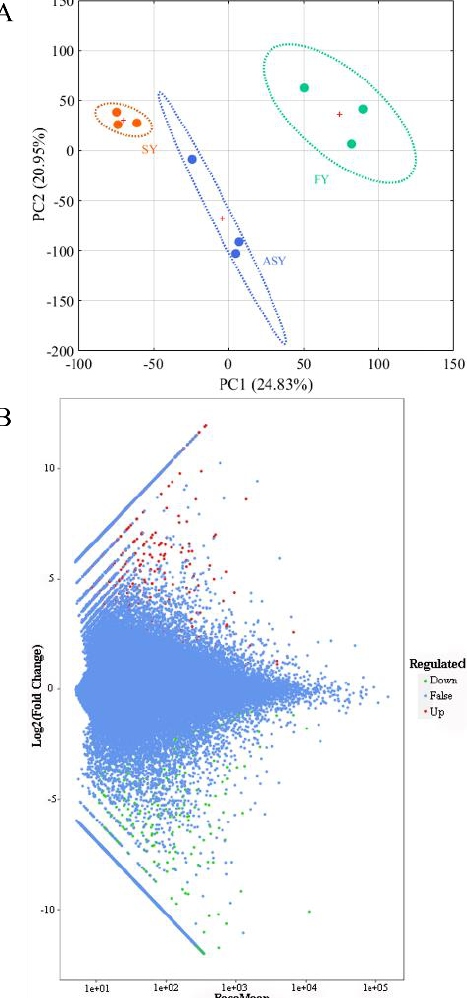
Figure 7. The unsupervised recognition and selection of different genes using sequencing data of F. cirrhosa . ( A ) The score plot of PCA; ( B ) the MA plot. SY: six-year samples. FY: four-year samples. ASY: aberrant six-year samples.